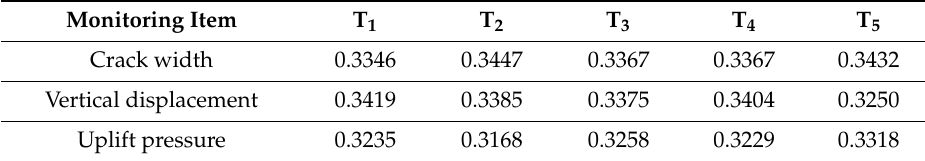
Table 12. The weights of all the monitoring items at five time periods for dam section #12.